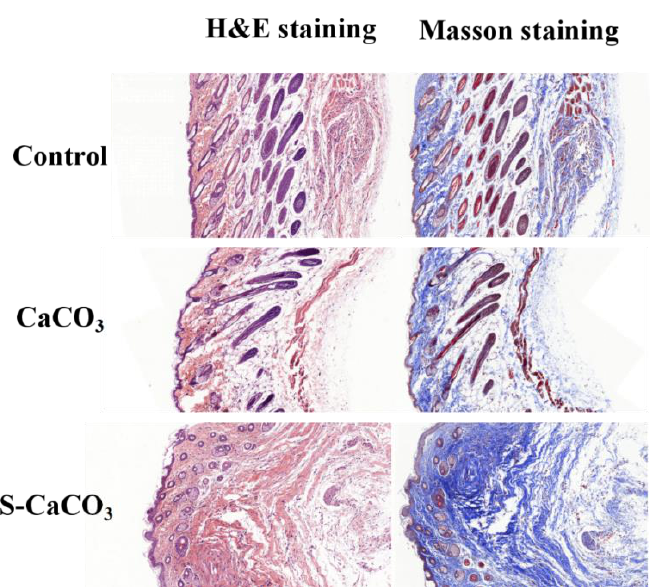
Figure 10. Histological analysis of wounds treated with CaCO 3 , CaCO 3 -chitason and untreated wound as the control after 10 d stained with H&E (left) and Masson ’ s trichrome (right). Scale bar, 200 µm.